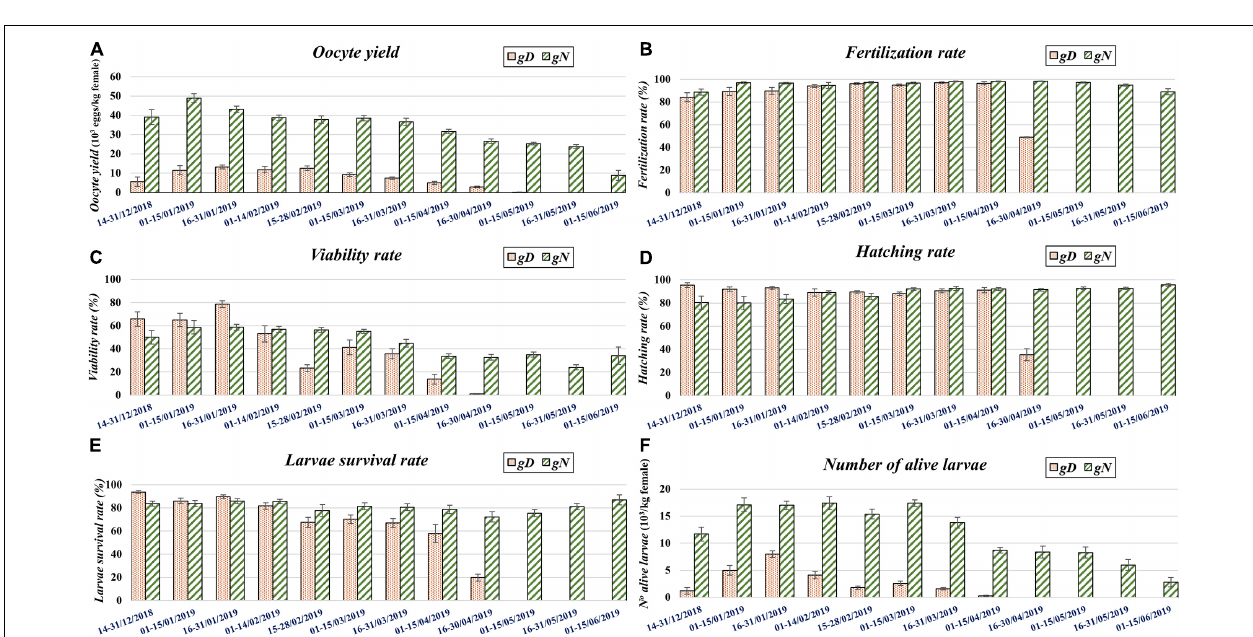
FIGURE 3 | The evolution of the daily oocyte yield per tank (D1, D2, N1, N2) from the beginning to the end of the spawning season.